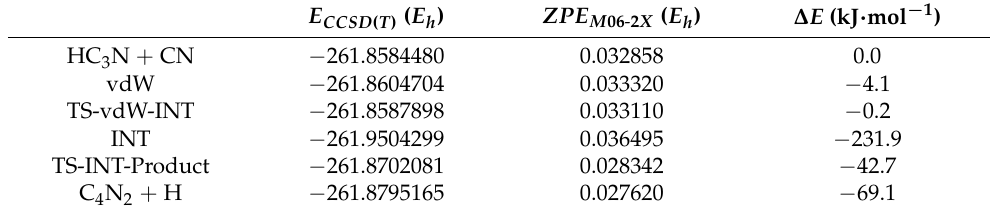
Table 1. Computed energies a the CCSD(T)/aug-cc-pVTZ//M06-2X/6-311+G(d,p) level of theory. E CCSD ( T ) ( E h )